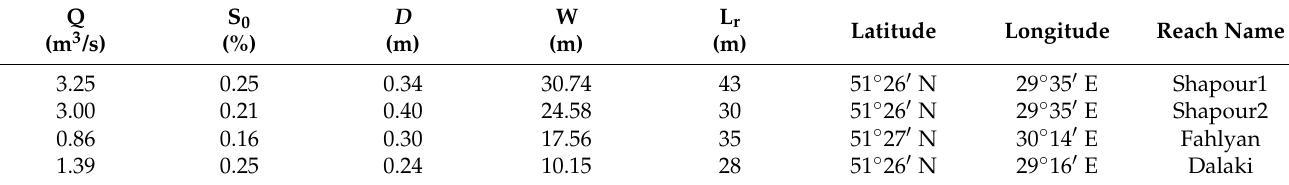
Table 1. Summary of general information of selected